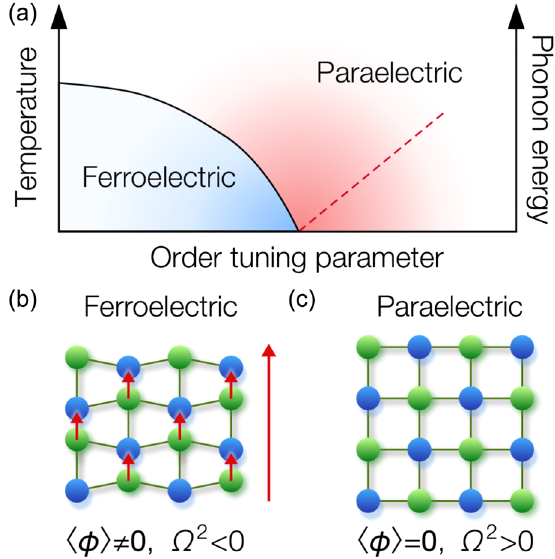
FIG. 1. (a) Schematic phase diagram of a quantum paraelectric material. The horizontal axis corresponds to a tuning parameter, such as pressure or isotope substitution, which controls the transition between the ferroelectric and paraelectric phases. The vertical axis is the temperature or energy, and the red dashed line in the paraelectric phase shows the optical phonon energy. Note that the phonon softens to zero energy at the paraelectric-to- ferroelectric transition point. The main goal of this paper is to demonstrate that this transition can also be controlled by changing the electromagnetic environment of the system, in particular, by placing a thin film of material in a cavity. (b),(c) Ferroelectric and paraelectric phases in the case of ionic crystals. Green (blue) circles indicate the ions with positive (negative) charges. The ferroelectric phase in (b) is characterized by a nonzero uniform displacement causing an electric polarization (red arrows), while the mean-phonon displacement is absent in the paraelectric phase in (c). The variables ϕ and Ω represent the phonon field and the bare phonon frequency, respectively (see Sec.